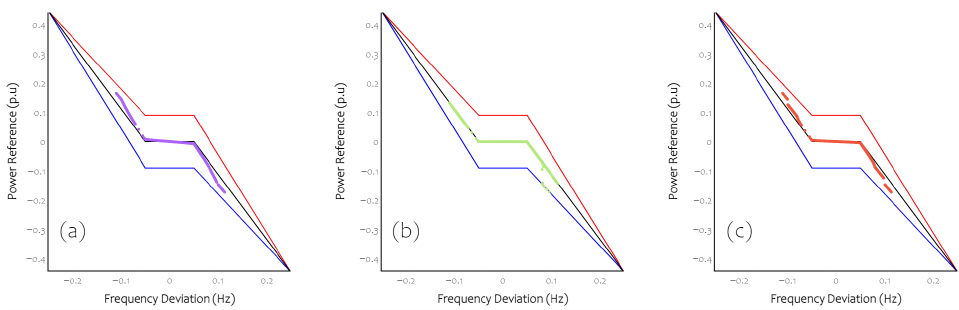
Figure 8. Controller performance of ( a ) Conventional FLC, ( b ) PID controller, and ( c ) Type-2 FLC.